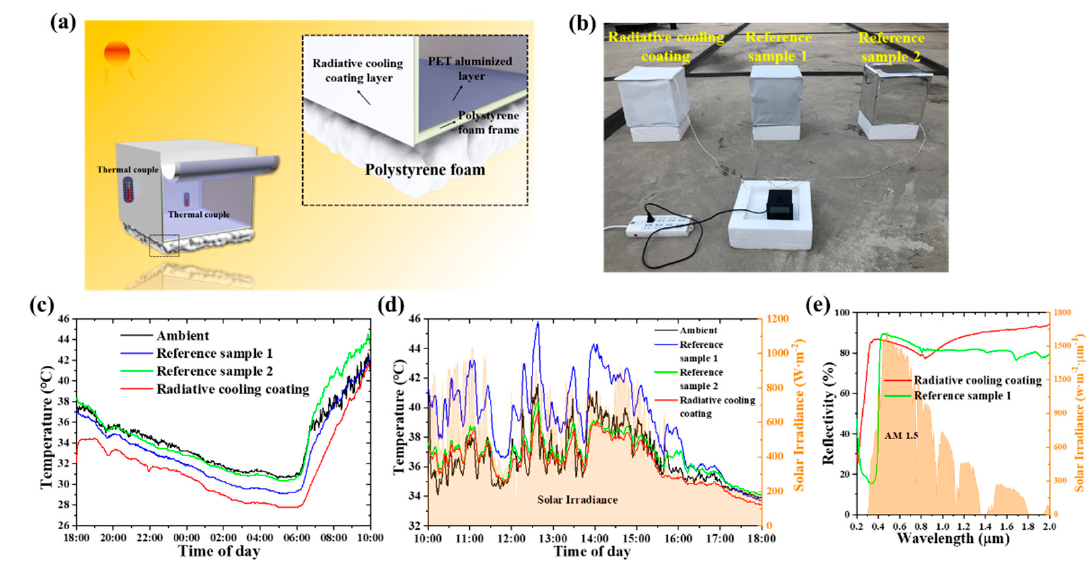
Figure 5. The rooftop measurement apparatus and the testing results: ( a , b ) The schematic and picture of the testing apparatus, respectively; ( c , d ) Nighttime (29 July 2019) and daytime (23 July 2019) test results of the rooftop measurements, respectively; ( e ) Solar reflectivity of the radiative cooling coating and commercial cooling coating.